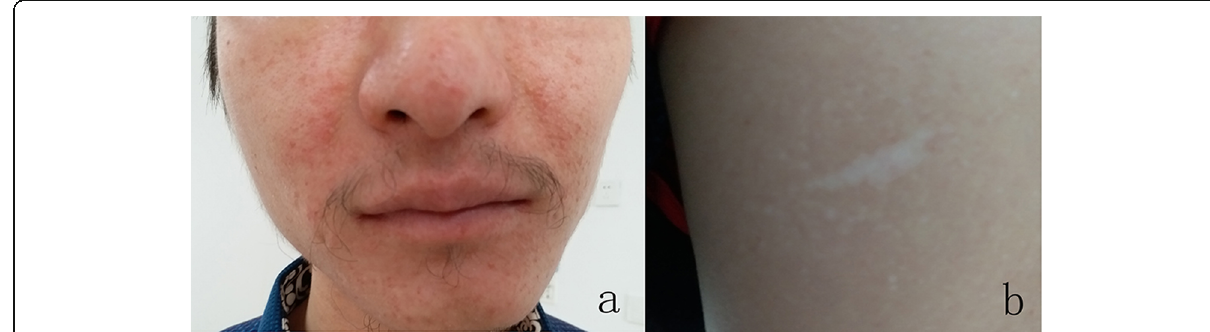
Fig. 1 Photographs of the paternal sample showing ( a ) facial angiofibromas and ( b ) hypopigmented macules on the